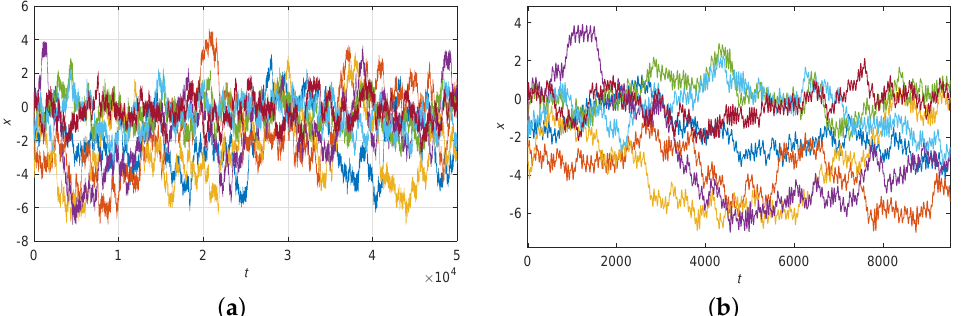
Figure 2. ( a ) Time series generated by the electronic circuit shown in Figure 1 for parameters γ = 0.1, α 1 = 1.5, α 2 = 1.3, α 3 = 0.1, C 1 = 0.9, C 2 = 0.6. ( b ) Zoom-in on the time series shown in ( a ).